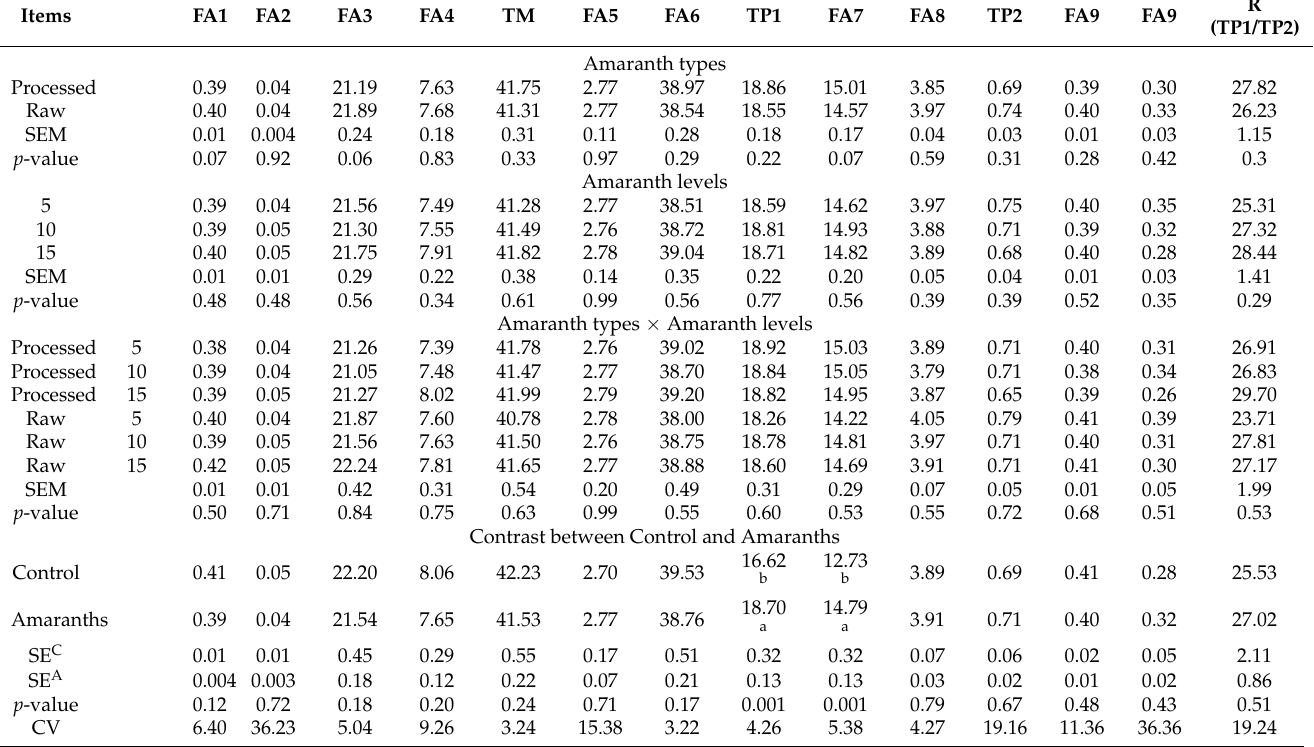
Table 6. Effect of trials diets on the egg fatty acids (%) in laying